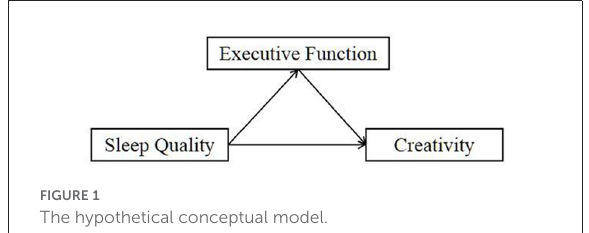
FIGURE1 The hypothetical conceptual